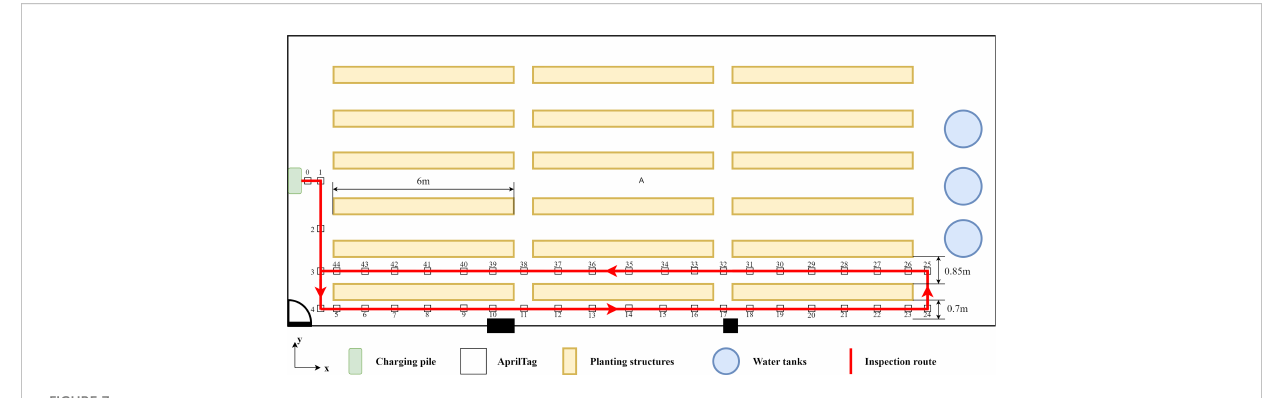
FIGURE 7 Schematic diagram of the experimental scene and inspection